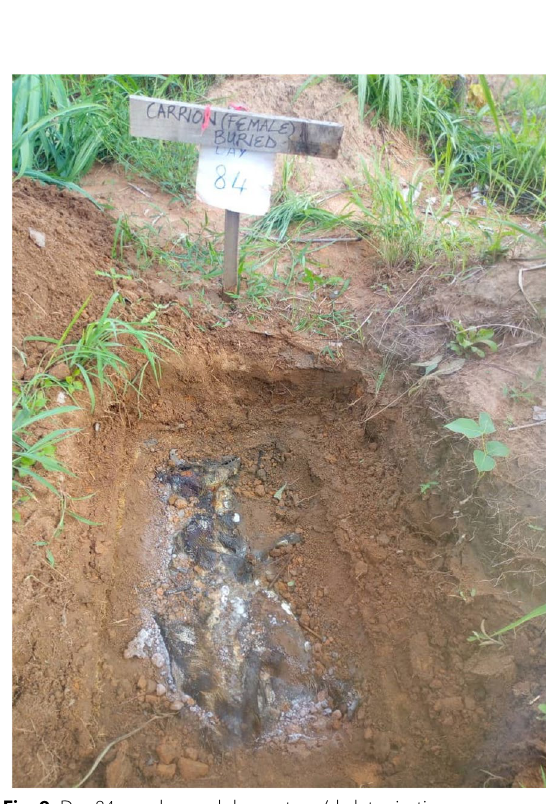
Fig. 9 Day 84 — advanced decay